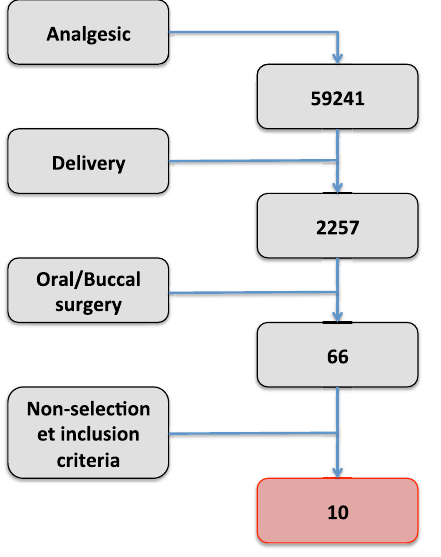
Fig. 3. Flow chart of the systematic literature review.